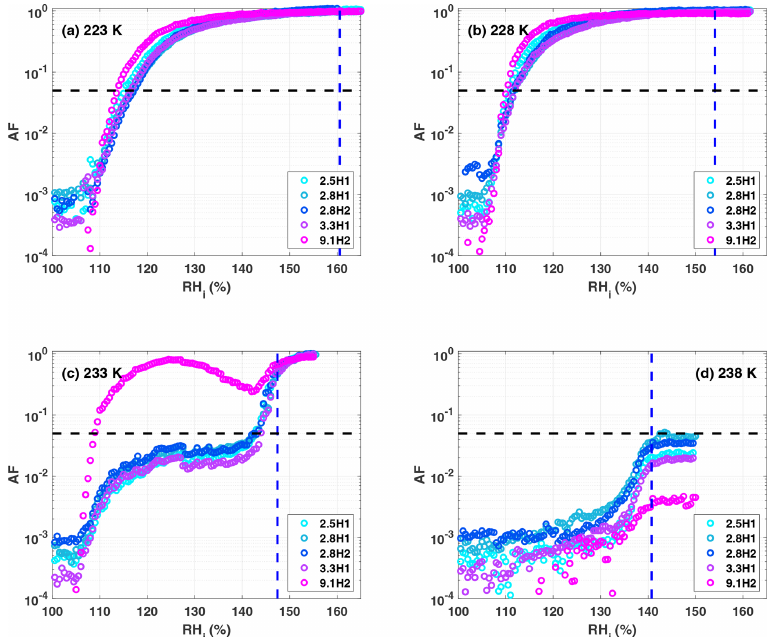
Figure A1. Activated fraction (AF) curves for the hydroxylated samples as a function of RH i at (a) 223K, (b) 228K, (c) 233K and (d) 238K. The blue dashed vertical line represents the RH i corresponding to water saturation. The black dashed horizontal line indicates the AF 0 . 05 threshold. The decrease in the AF for the 9.1H2 sample (magenta circles) in panel (c) was reproducible but disappeared at 231K (not shown).